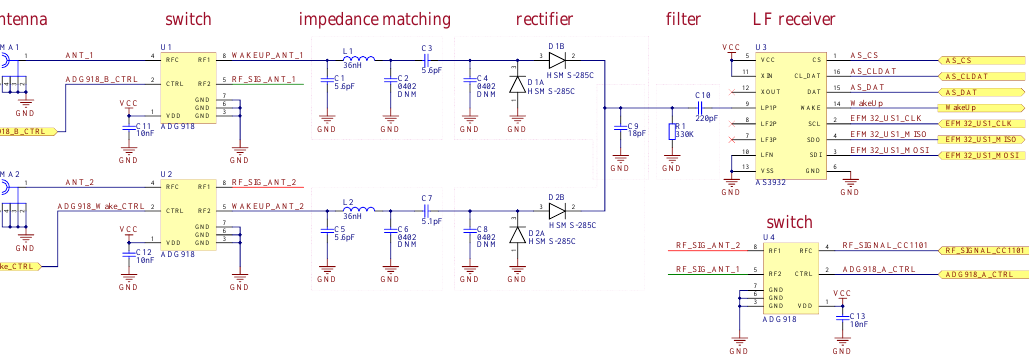
Figure 4. Schematic of the receiver front-end with two antennas including matching networks rectifiers AS3932 wake-up receiver and antenna